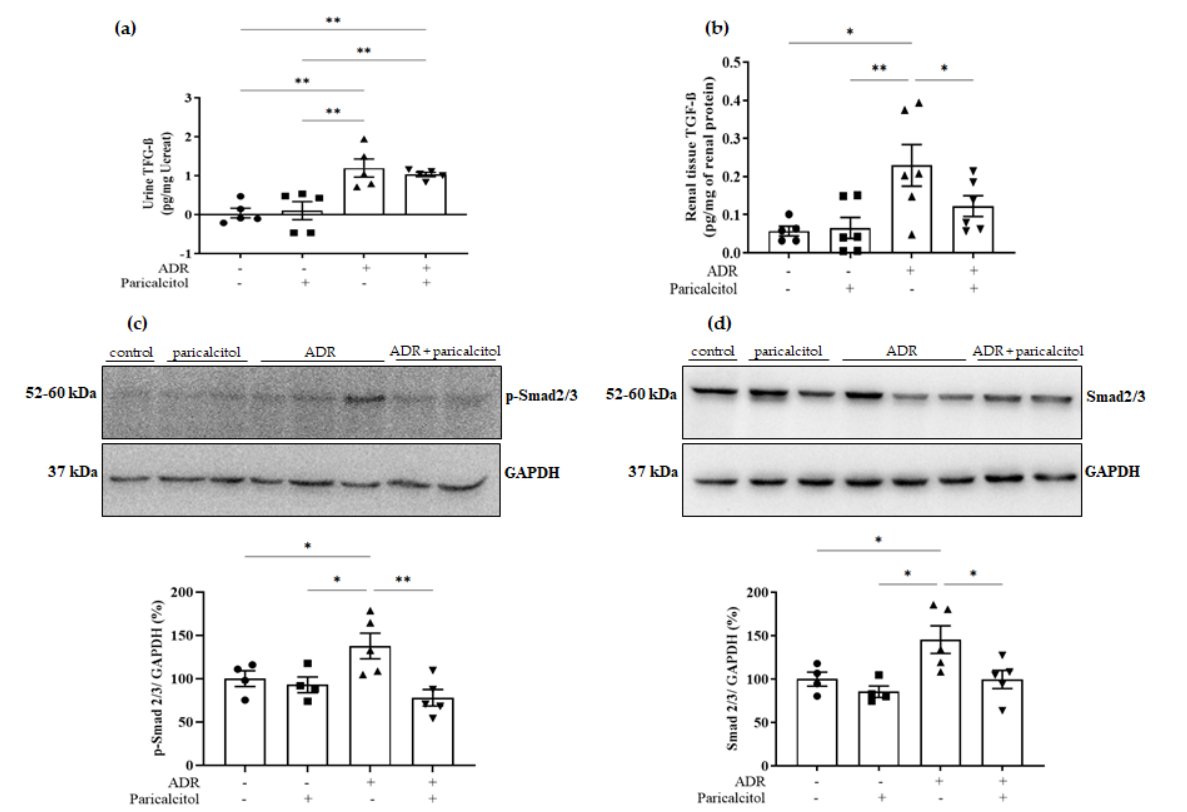
Figure 9. ( a ). Urine TGF- β 1 levels. ( b ). Renal tissue TGF- β 1 levels, n = 5–7 for each group. ( c ). Densitometric ratios among p-Smad2/3. ( d ). Densitometric ratios among Smad2/3. Densitometric ratios among these markers and GAPDH were calculated, and data were expressed compared with the control group. The control value was designated as 100%. Data are expressed as mean ± SEM. n = 4 – 5 for each group. Data from the control (dots), paricalcitol (squares), ADR (up triangles), and ADR + paricalcitol (down triangles) groups. * p < 0.05; ** p < 0.01.